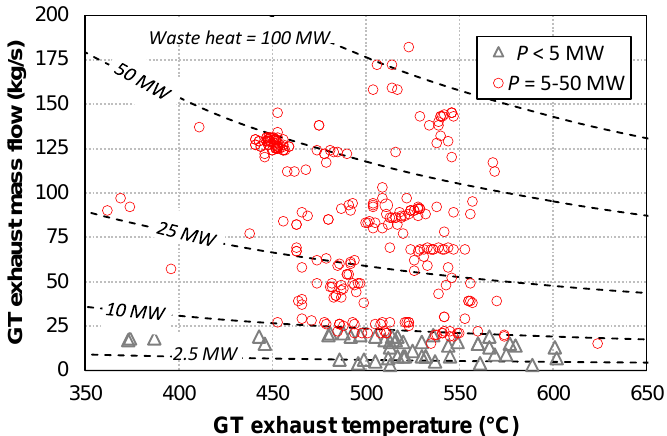
Figure 1. Overview of industrial GT exhaust temperature, air flow, and waste heat ranges calculated at full load conditions, assumed to cool the exhaust gas down to 80 °C.